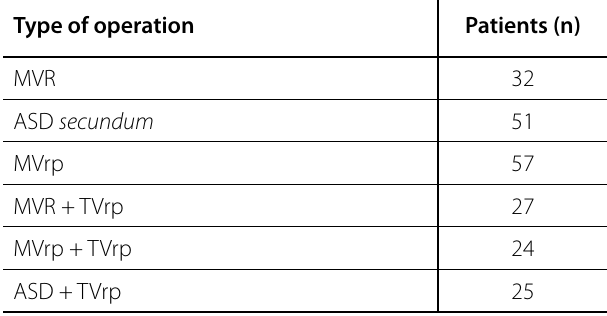
Table 2. Types of robotic cardiac operations in the study. Type of operation